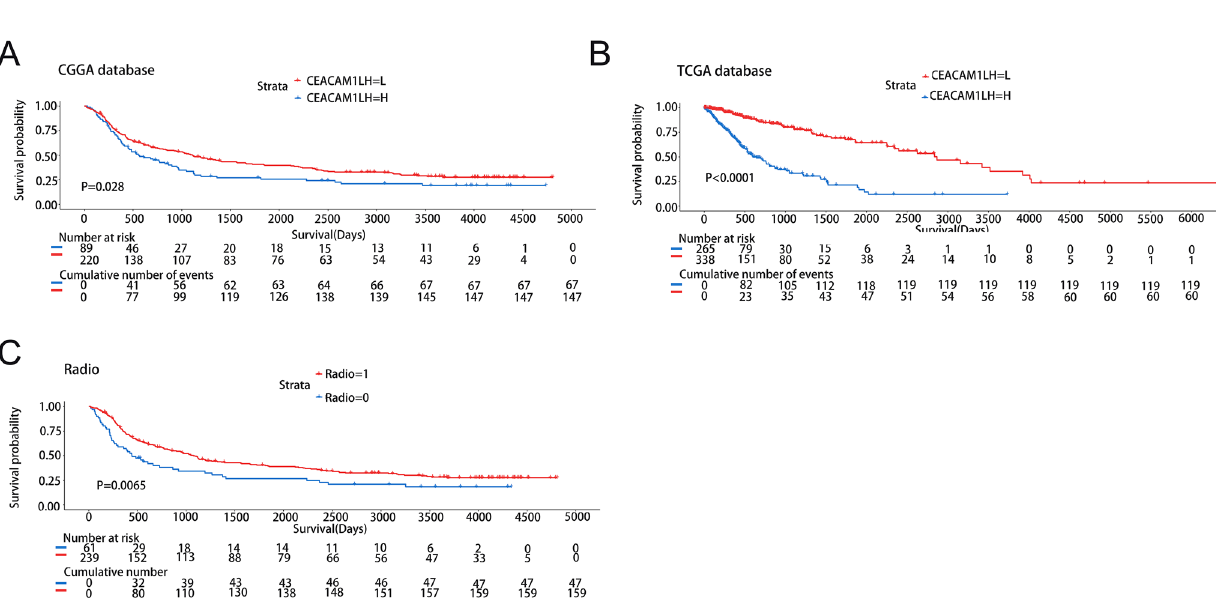
Fig. 9 Survival prediction of CEACAM1/Radio in glioma. A , B Kaplan–Meier analysis of CEACAM1 expression in the Chinese Glioma Genome Atlas (CGGA) and The Cancer Genome Atlas (TCGA) databases. The cutoff of the group is the median expression of CEACAM1.The signifi- cance of the prognostic value was tested by a log-rank test. C Kaplan Meier analysis of Radio in the Chinese Glioma Genome Atlas (CGGA)